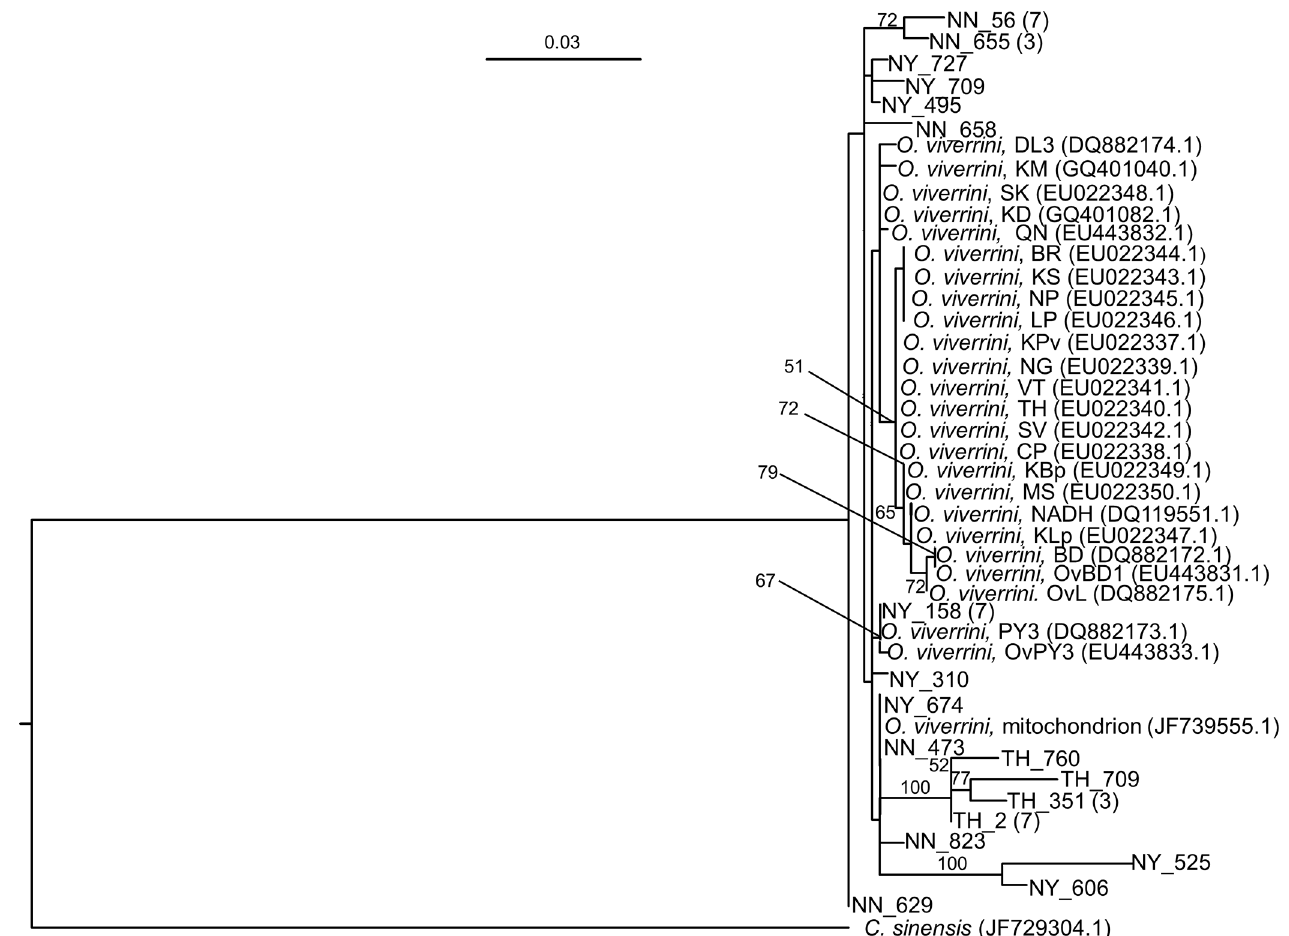
Fig 5. The Randomized AxeleratedMaximumLikelihood tree based on the nad1 sequences of O . viverrini . The alignmentof 688 nucleotide sequenceswithout gaps and 18 variants from three villages(NY = Na-Yao, NN = Na-Ngam, TH = Thoong-Heang) were analyzed. O . viverrini Thai isolates (BR, KS, LP, NP, KPv, MS, KLp, KBp, SK, NADH1), Lao PDR isolates (CP, NG, SV, VT, KM, O . viverrini mitochondrion partial genome), Vietnamese isolates (BD, OvBD1, OvL, PY3, OvPY3, QN, DL3) and a Cambodianisolate(KD) were used as the referenceisolates. The percentages of 1,000 replications (bootstraps) of more than 50% are shown at the nodes. The number of samples is in